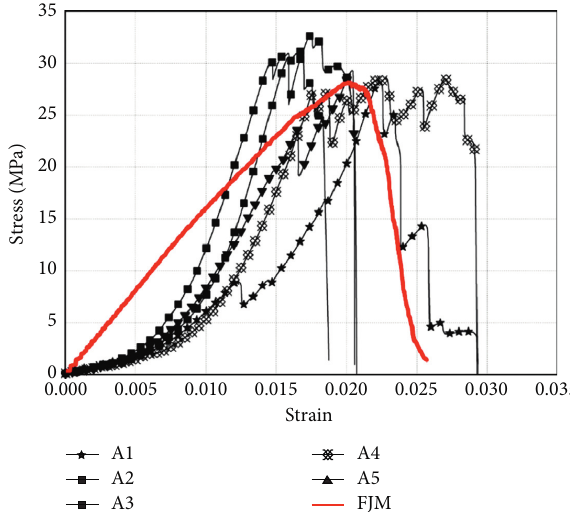
Figure 9: Comparison of stress-strain curves obtained by the uniaxial compression test and FJM